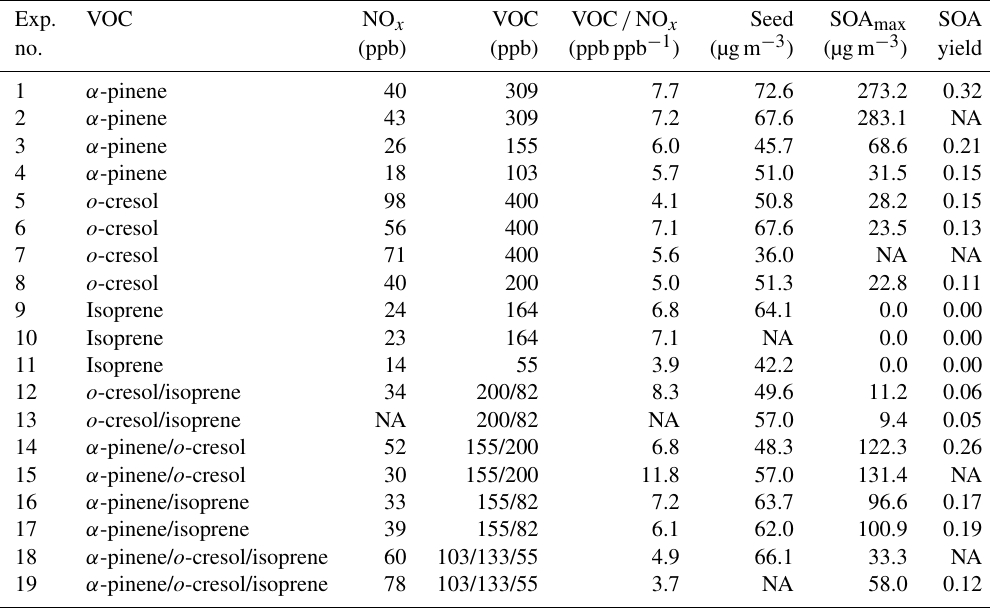
Table 1. Summary of initial experimental conditions.